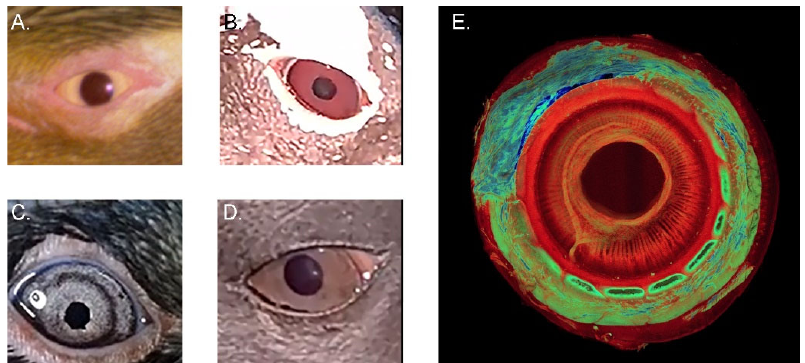
Figure 7. Irides of selected species of penguin. ( A ) Yellow ‐ eyed penguin Megadyptes antipodes ; ( B ) Gentoo penguin Pygoscelis papua ; ( C ) Little penguin Eudyptula minor —note that the pupil appears slightly octagonal in this photograph; ( D ) King penguin Aptenodytes patagonicus; ( E ) The intrinsic structure of the king penguin iris, as reconstructed from raw data available at https://figshare.com/search?q=10.17608/k6.auckland.c.5599341 accessed on 31 May 2022 (Digital Sci ‐ ence, London, UK) using CT Vox 3.3 (Bruker MicroCT, Kontich, Belgium). Credit: PWH. Sivak and Vrablic [70] have published on the histology of the Adélie penguin Pygos ‐ celis adeliae iris. As in other birds, both iris sphincter and dilator muscles are composed of striated muscle fibres, and the sphincter, in particular, is well developed, occupying ‘most of the cross ‐ sectional area of the iris’. Given the nature of the muscle, it may be under voluntary control; during cataract surgery, atracurium has been used with varying de ‐ grees of success to induce mydriasis [5]. Sivak and Vrablic [70] also noticed a bend tilting towards the cornea midway between the iris root and pupil, with the suggestion being that the iris near the pupil rests on the anterior lens in such a way as to apply force to the lens equatorially and increase the change in the lens curvature.